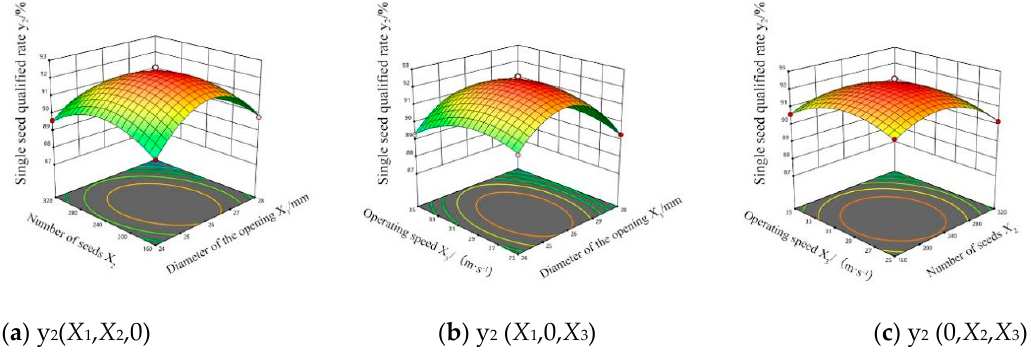
Figure 16. Effect of test factors on qualified rate.